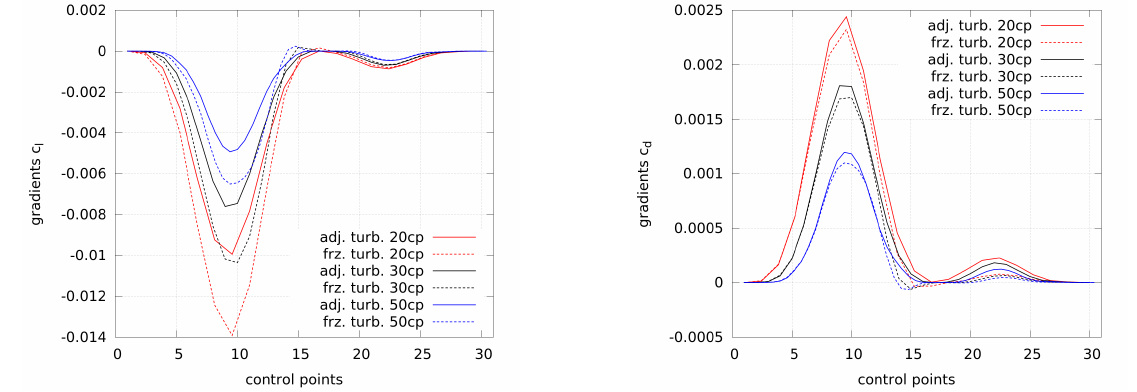
Figure 18. Gradients of the first optimization step for lift and drag objective of the DU 93-W-210 at AoA = 6 ◦ . Frozen as well as adjoint turbulence are used. The number of control points is labeled as “XXcp”. The control points start from the trailing edge on the suction side, pass the leading edge and end at the trailing edge on the pressure